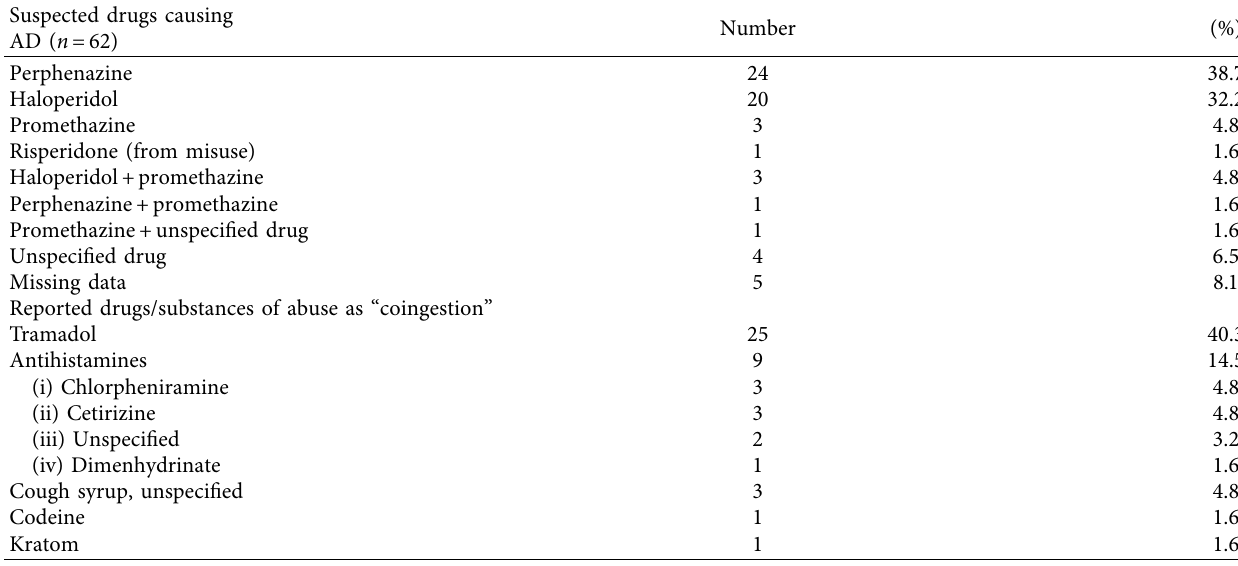
Figure 1: Number of cases recorded per month. Table 3: Suspected drugs ingested by patients with acute dystonia (AD) in this